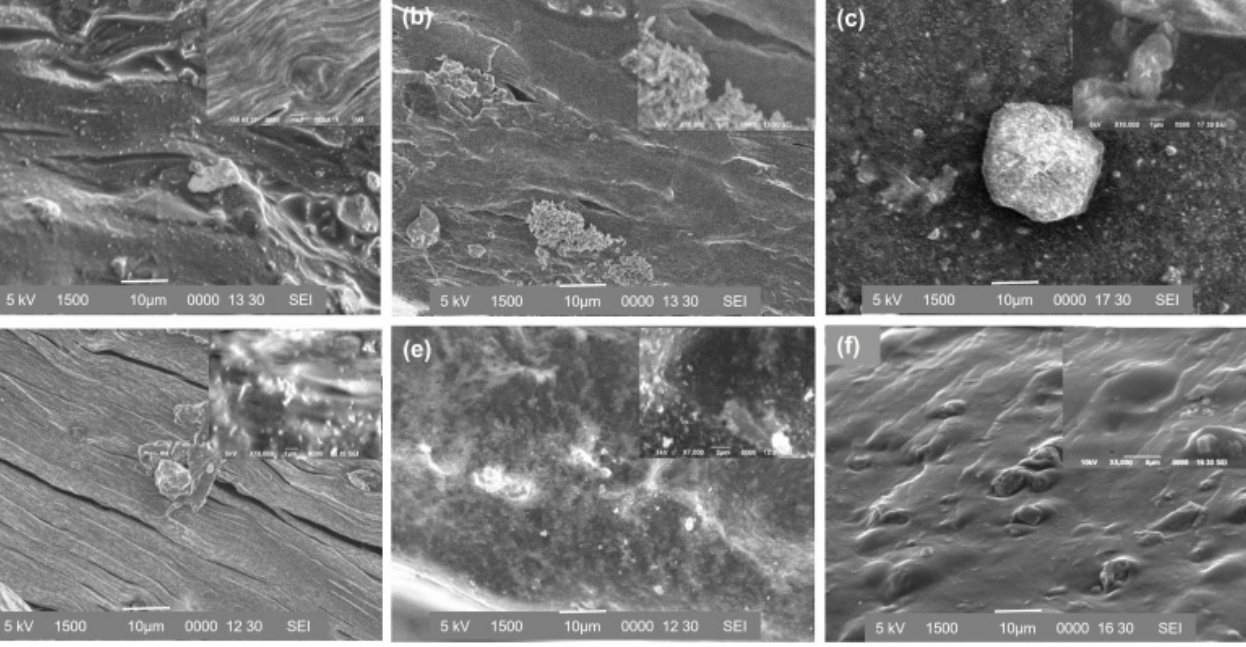
Figure 8. SEM images of BSA-loaded hydrogels: ( a ) A4.7-100, ( b ) M6.4-100, ( c ) A6.4-100, ( d ) M6.4-50, ( e ) M6.4-25, and ( f ) PZ-6.4.